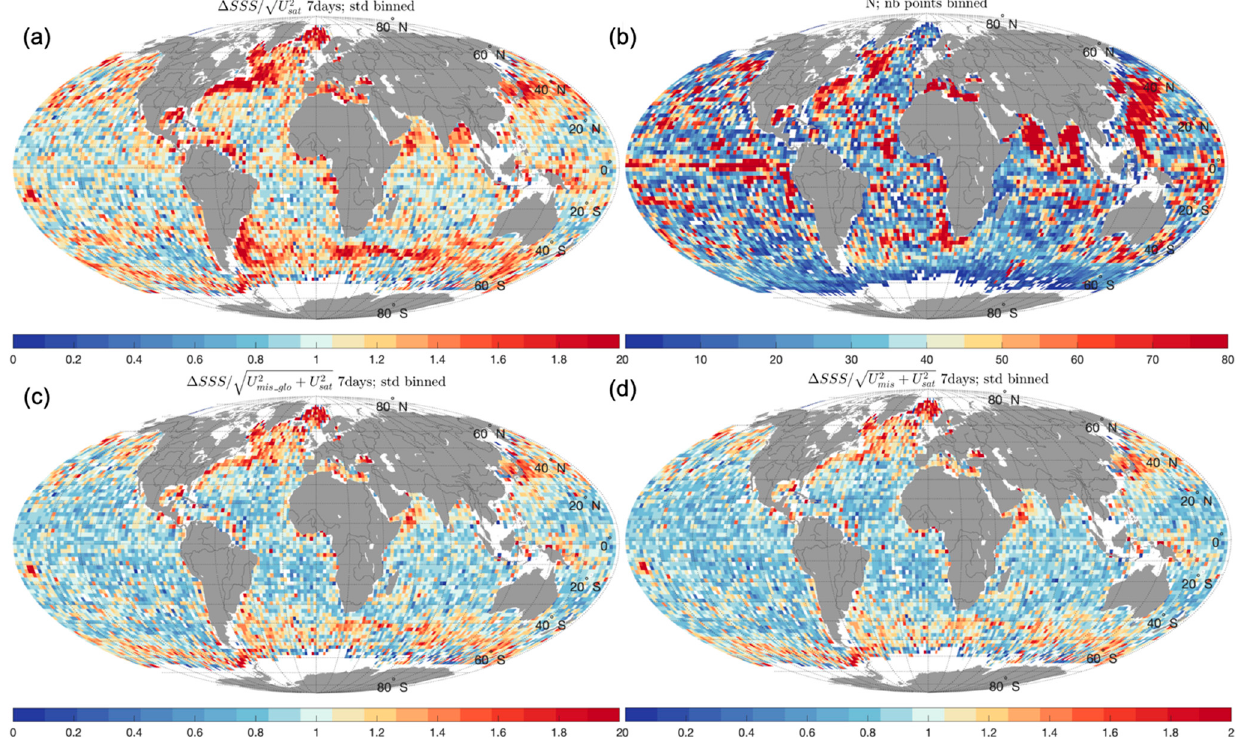
Figure 6. Standard deviations of CCI-Argo differences normalized by the various sources of uncertainties, in 2° boxes. Only boxes with more than three Argo measurements are considered. ( a , c , d ) Maps of the STD of the differences normalized (Equation (1)) by ( a ) U sat ; ( c ) U sat and U mis_glo ; and ( d ) U sat and U mis . ( b ) Number of collocated points in each 2° box.